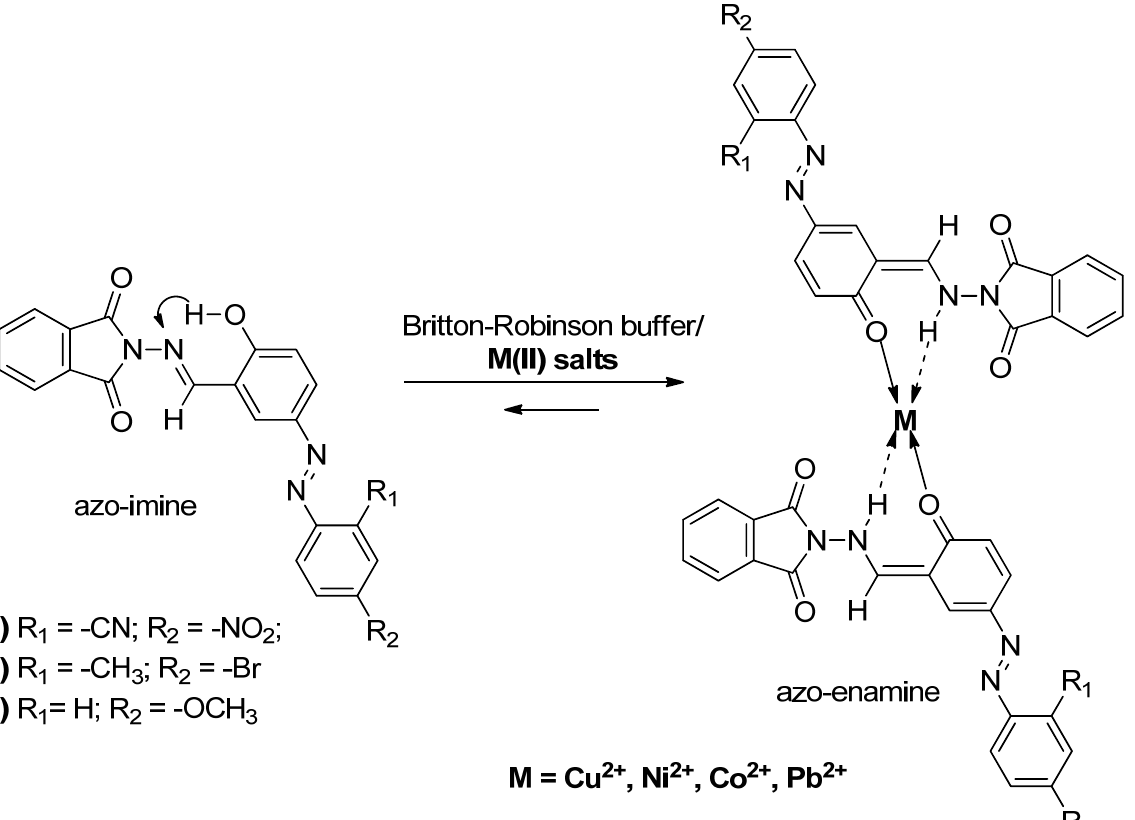
Scheme 1. Coordination of the metal ions (Cu(II), Ni(II), Co(II), Pb(II)) in complexation with N-phthalimide azo-azomethine derivative.